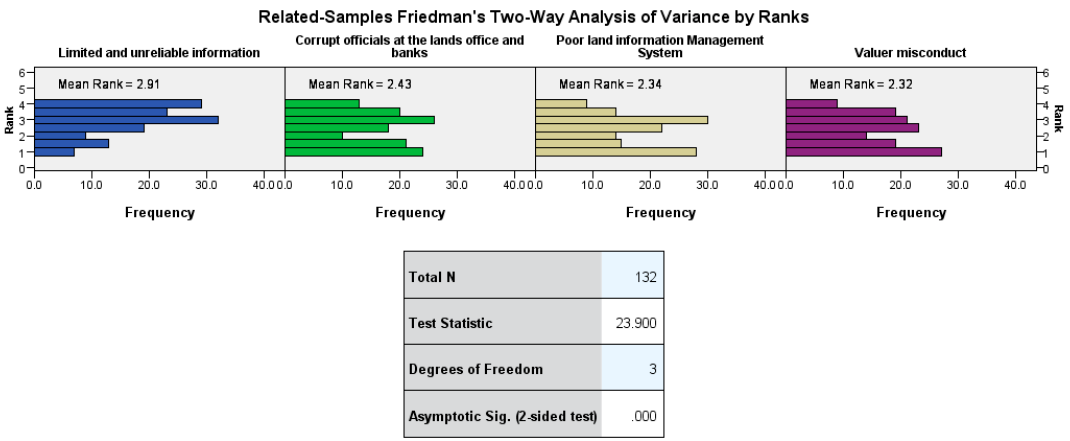
Figure 1. The Friedman ANOVA non-parametric test.